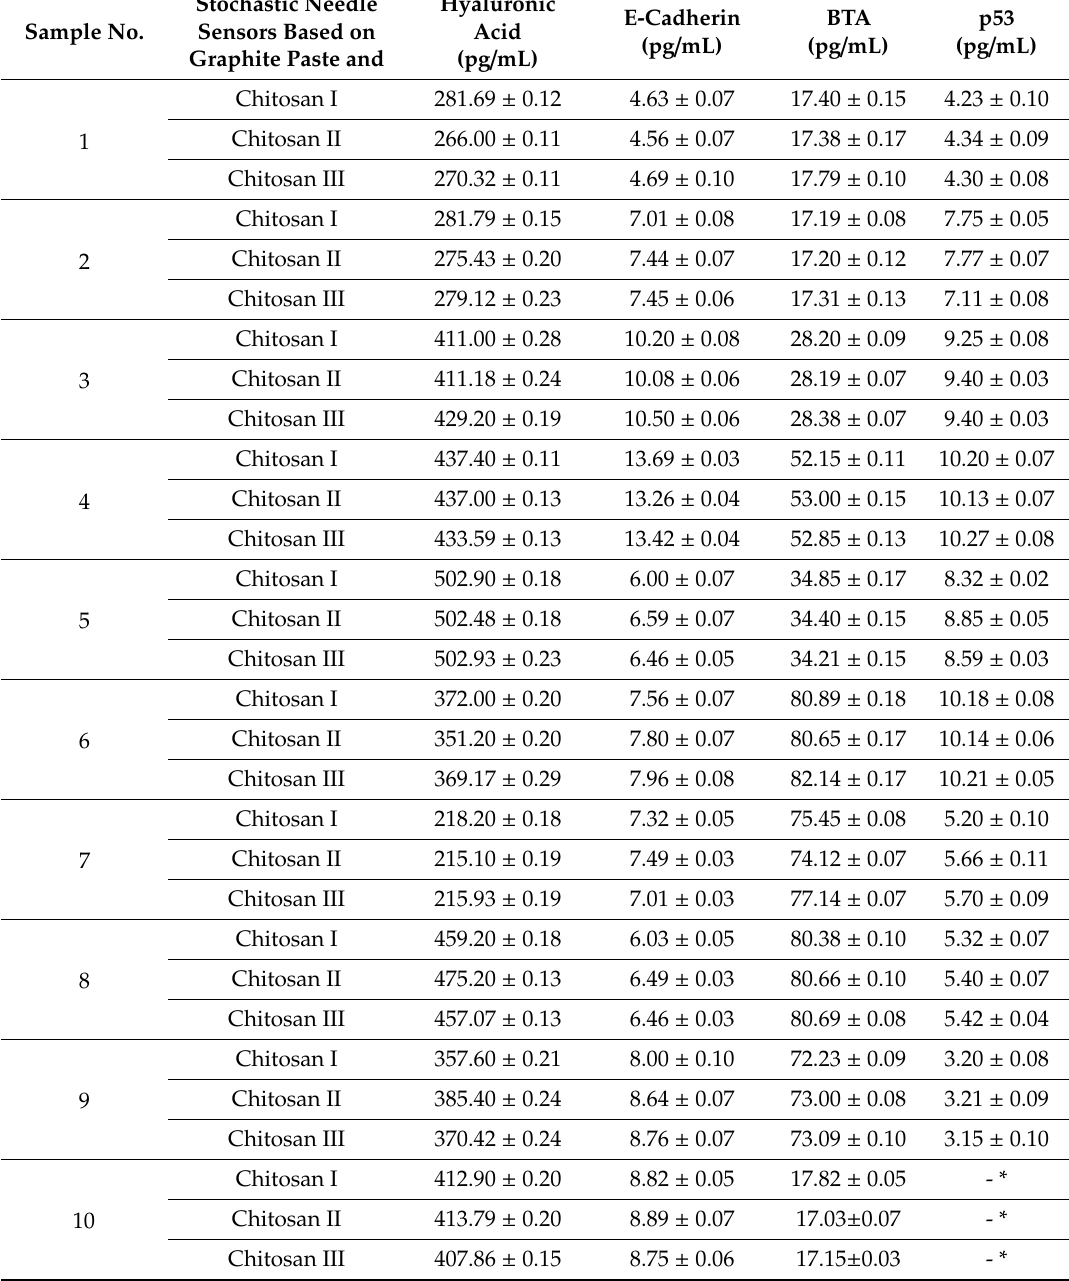
Table 4. The recovery of p-53, E-cadherin, BTA. and hyaluronic acid in tumor tissue samples using the stochastic needle sensors (N =